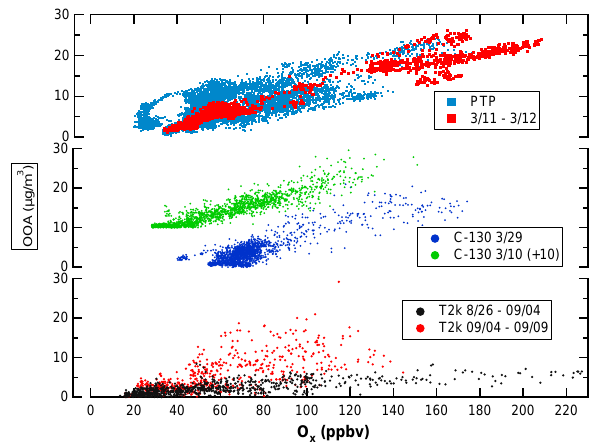
Fig. 3. Correlations of OOA with O x at PTP (top panel; 11 days, 1min averages), two research flights (RF12 on 3/29 and RF3 on 3/10) aboard the C-130 aircraft in Mexico City (middle panel: 12- s averages, green points are offset 10µg/m 3 ) , and La Porte, Texas (bottom panel: 10min averages, divided into two time periods).